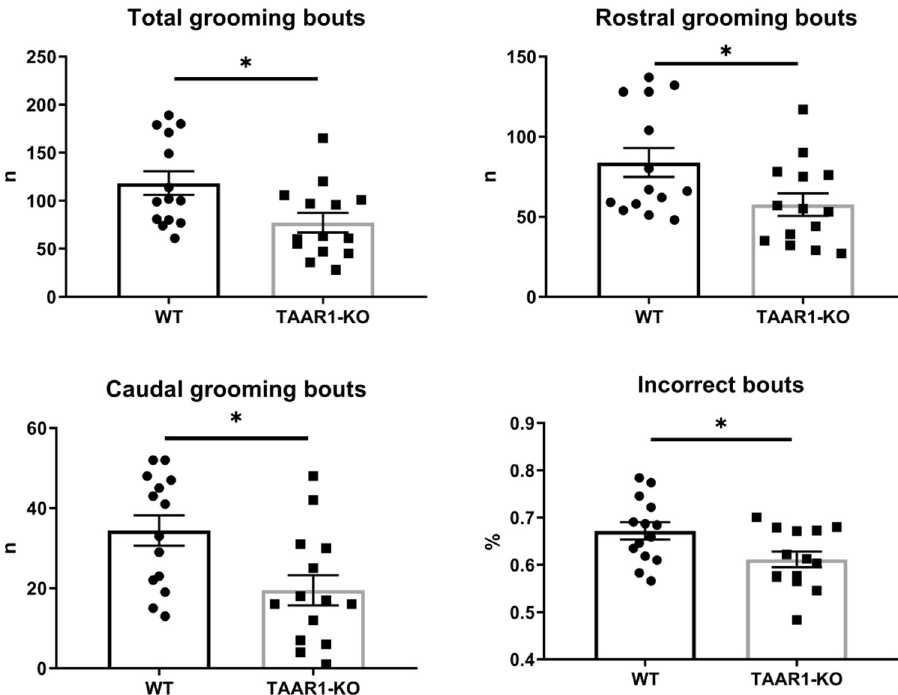
Figure 3. The TAAR1 knockout (KO) mice display altered self-grooming behaviors and aberrant patterning. WT—wild type control mice. Data are presented as mean ± SEM (n = 14). * p < 0.05, vs. control Mann–Whitney U-test.